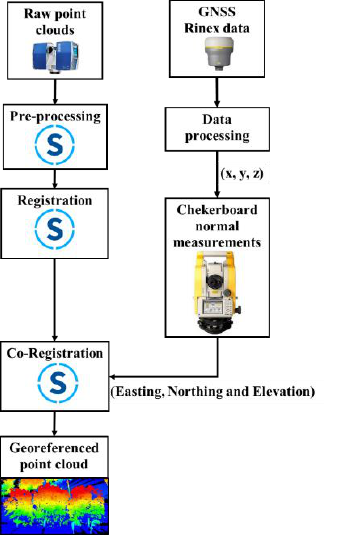
Figure 4. Overall methodology framework for TLS, TS, and GNSS data integration for generating georeferenced point cloud.